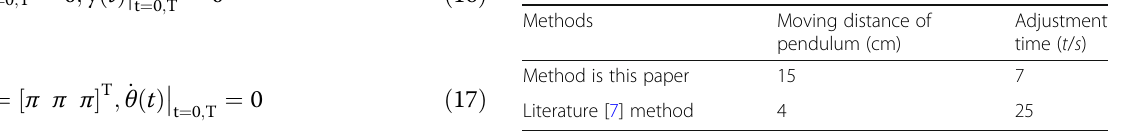
Table 1 The automatic swing-up adjustment control